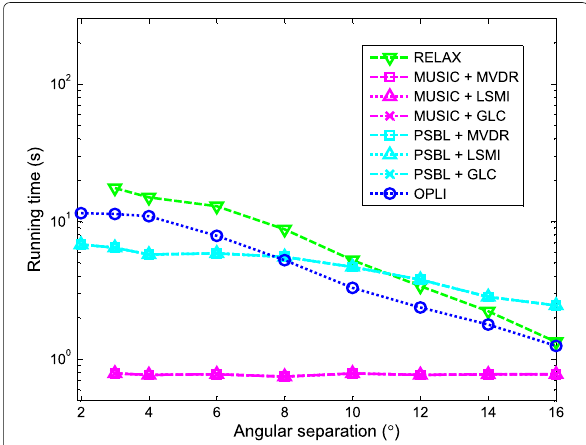
Fig. 11 Running time versus the number of snapshots